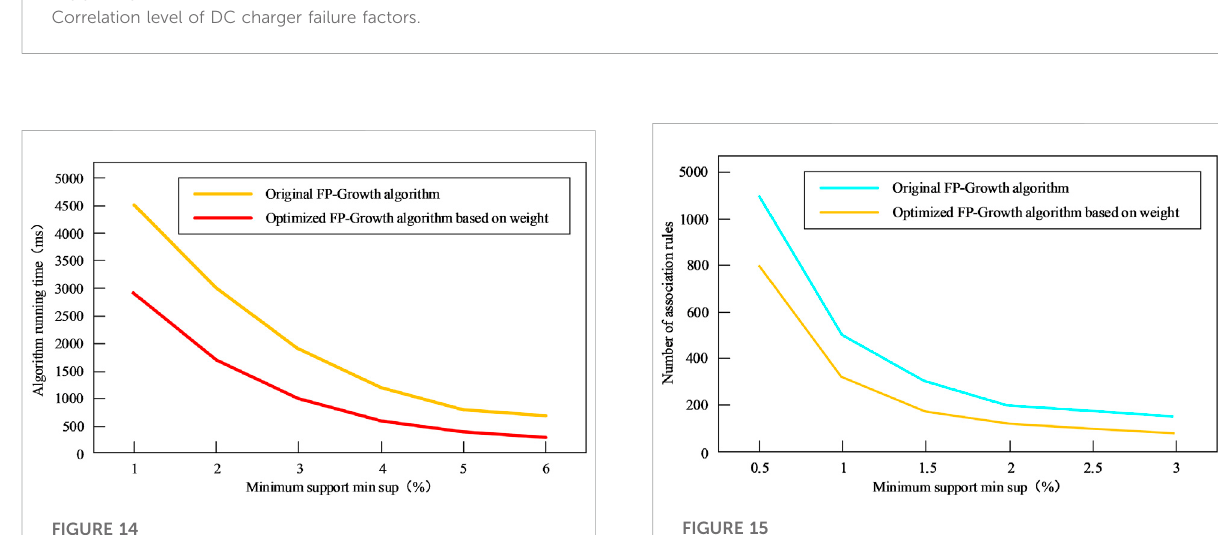
FIGURE 15 The number of association rules changes with the minimum